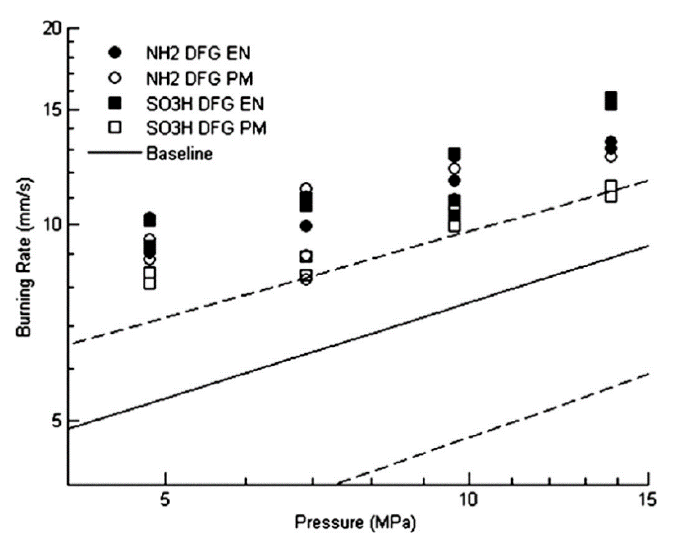
Figure 20. Burning rates of propellants with decorated graphene. Open symbols represent physical mixes and closed symbols encapsulated catalysts. Solid line is the baseline propellant burning rate, and dashed lines are the 95% confidence interval for the baseline propellant burning rate. Reprinted with permission from ref. [54]. Copyright 2017